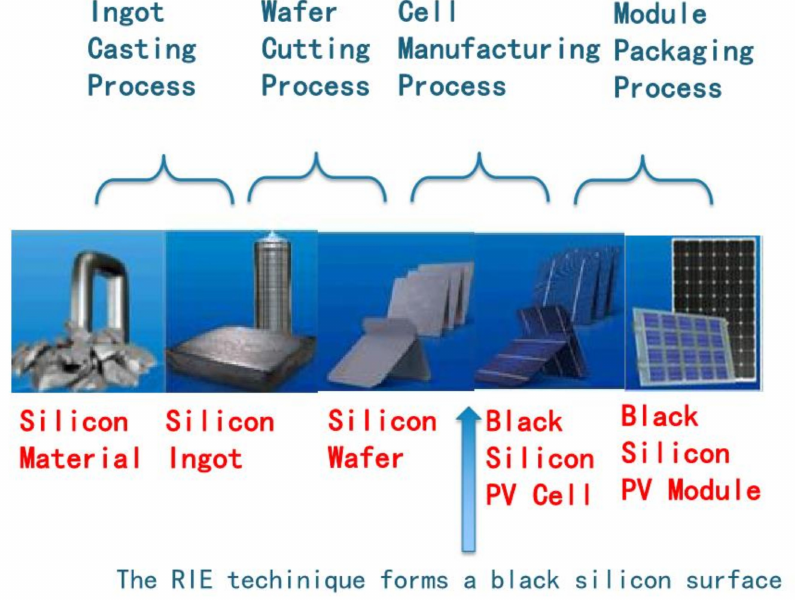
Figure 1. The production processes of the black silicon PV module.